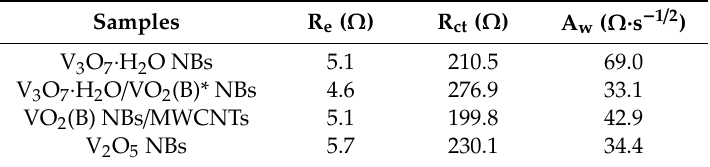
Figure 9. Nyquist plots ( a ) and dependences ( b ) of real resistance (Z′) on reciprocal of square root of angular frequency (ω) for all samples; the inset in ( a ) illustrating the equivalent circuit. Table 1. Fitted values of R e , R ct and A w for all prepared samples.